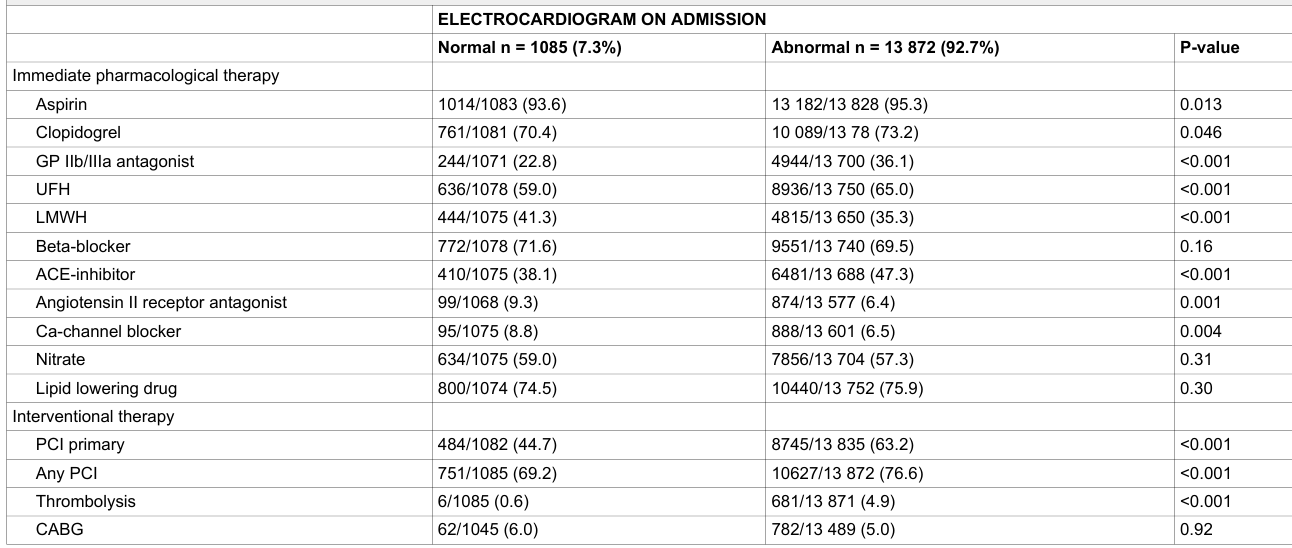
Table 2 Immediate therapy according to the patient’s ECG on